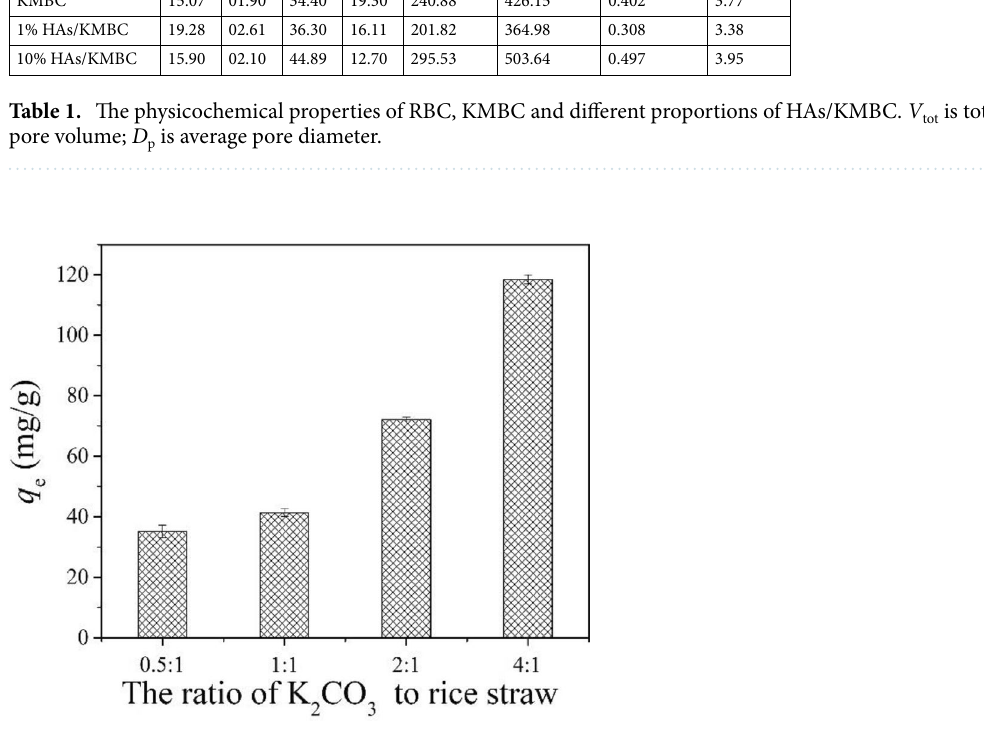
Figure 2. Effect of the ratio of K 2 CO 3 to rice straw on TC removal by KMBC. C 0(TC) = 50 mg/L, m / V = 0.1 g/L, T = 25 °C, t = 26 h, pH =